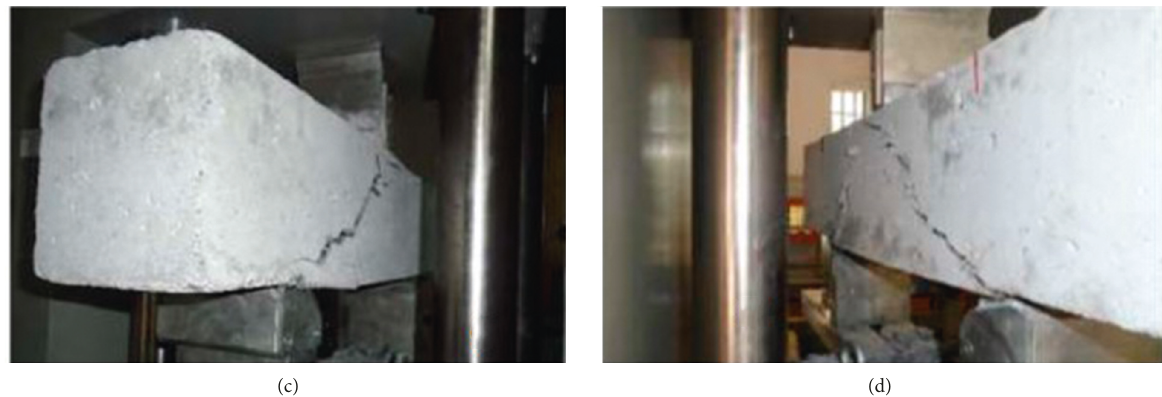
Figure 12: (a) Photos of failure mode of tested beams with reinforced bar, control beam, (b) photos of failure mode of tested beams with reinforced bar, at 0.25% strength beam, (c) photos of failure mode of tested beams with reinforced bar, at 0.50% strength beam, (d) photos of failure mode of tested beams with reinforced bar, at 0.75% strength